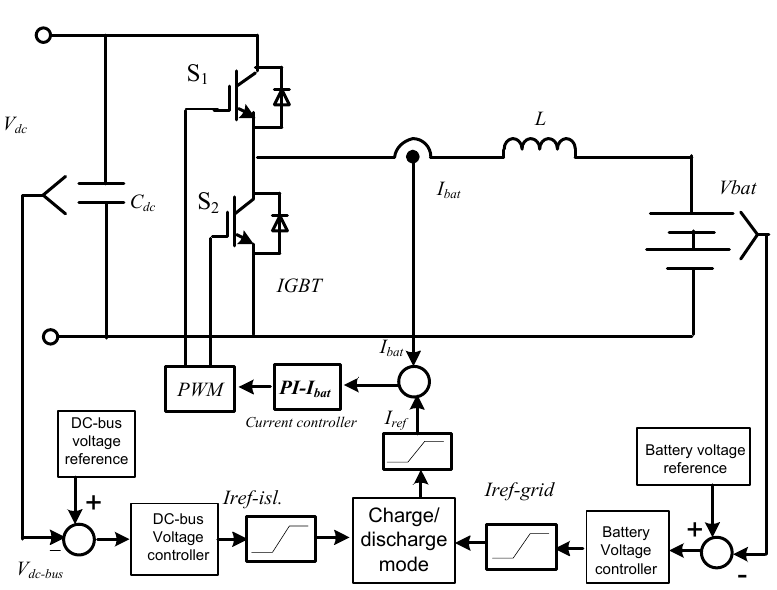
Figure 5. Control scheme of battery energy storage.